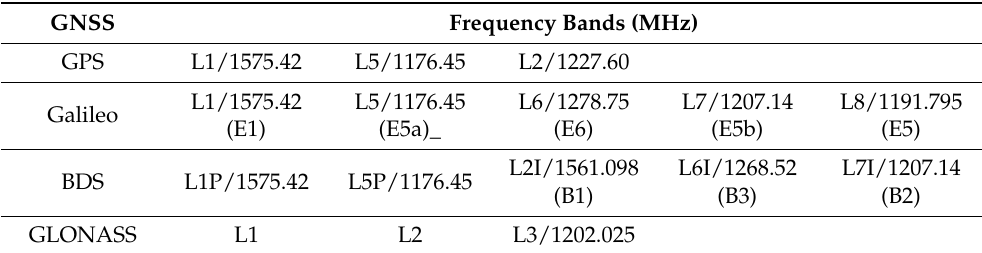
Table 1. Observed signals of multiple